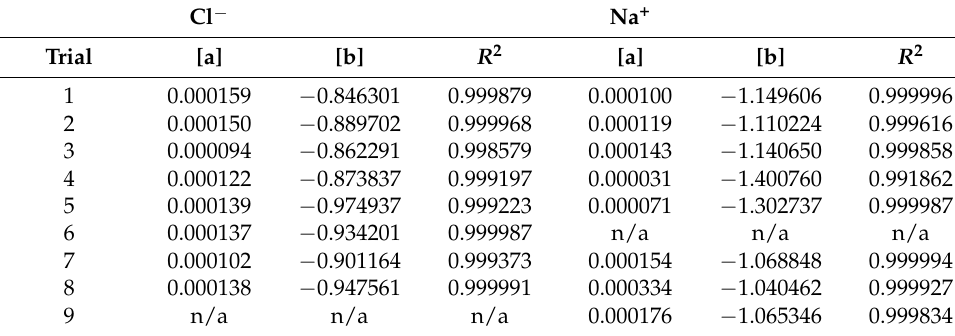
Table A8. Ion decline parameters following dilution. k obs = [a](t = n in hrs)[b].